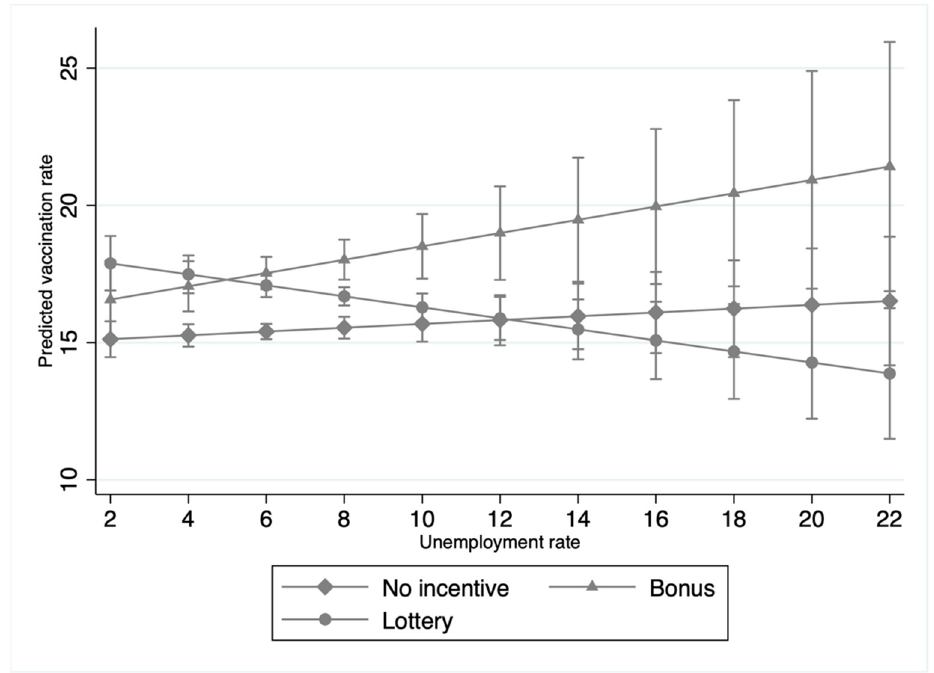
Figure 3. Interaction effects of COVID-19 vaccination incentive policies and unemployment rates (Model 5 in Table 3).